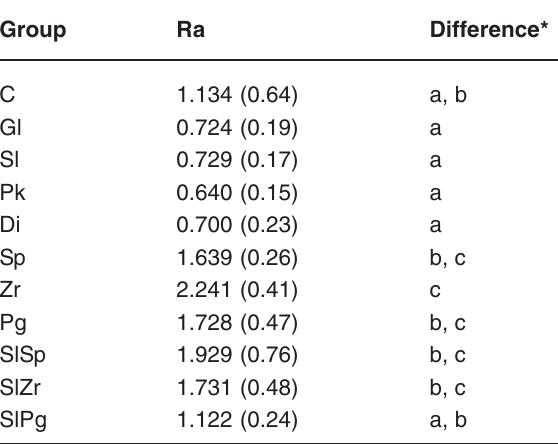
Table 3- Mean (SD) of surface roughness and differences between groups for Ceramco III